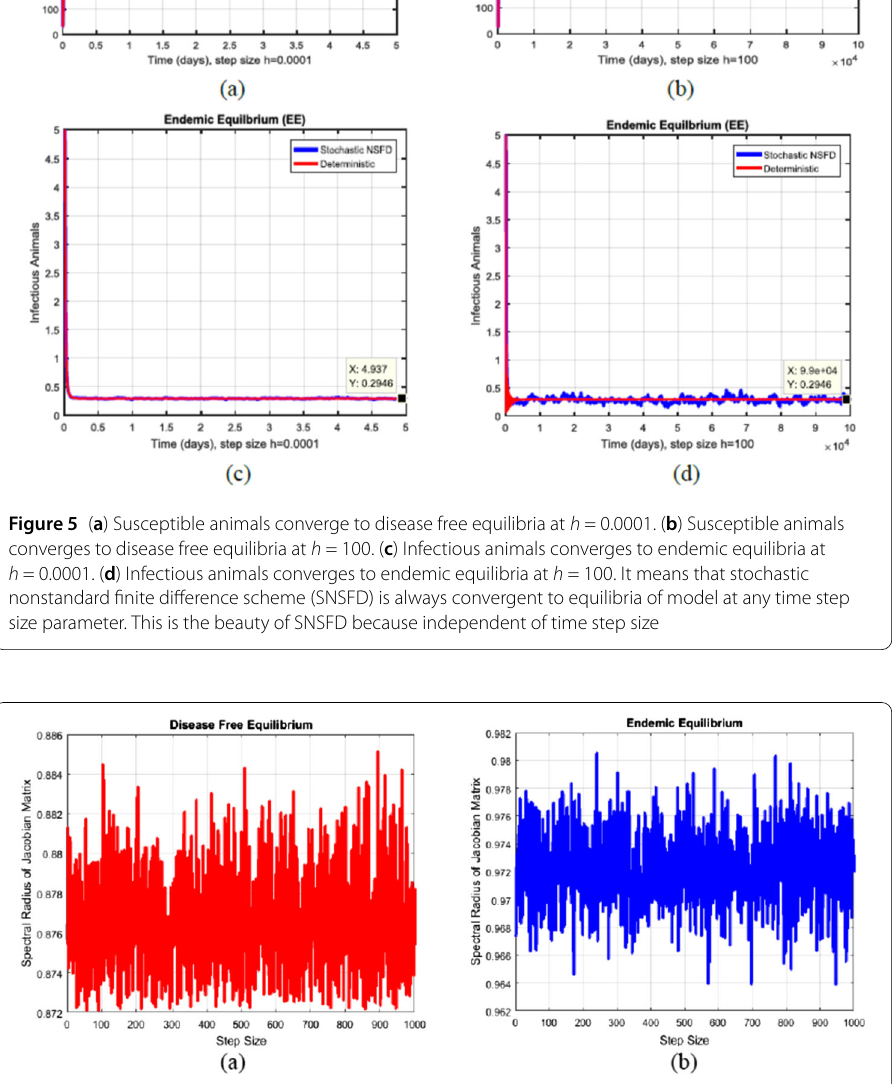
Figure 6 ( a ) Spectral Radius for DFE. ( b ) Spectral Radius for